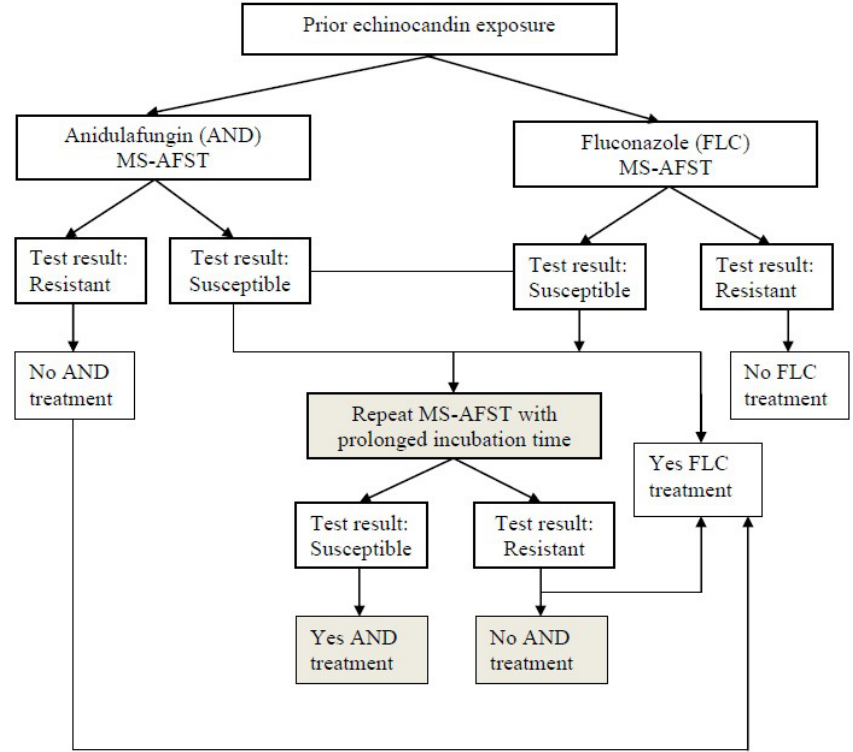
Figure 1. Potential treatment of invasive C. glabrata infection based on mass spectrometry– antifungal susceptibility testing (MS-AFST) results. In a clinical context of prior echinocandin exposure, results of susceptibility or resistance to anidulafungin and/or fluconazole within 3 h or, in cases of